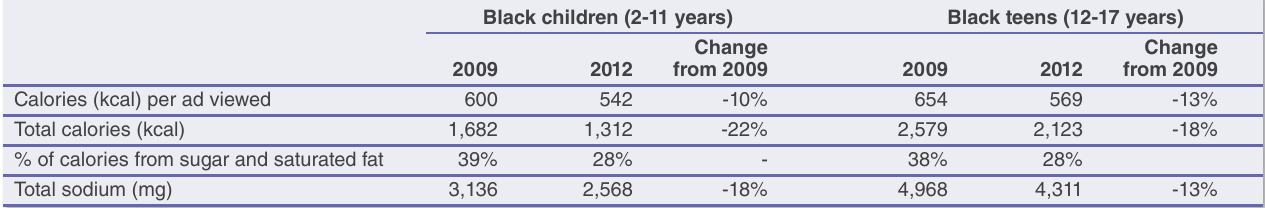
Table 43. Total nutrient content of items in TV ads viewed by black youth every day